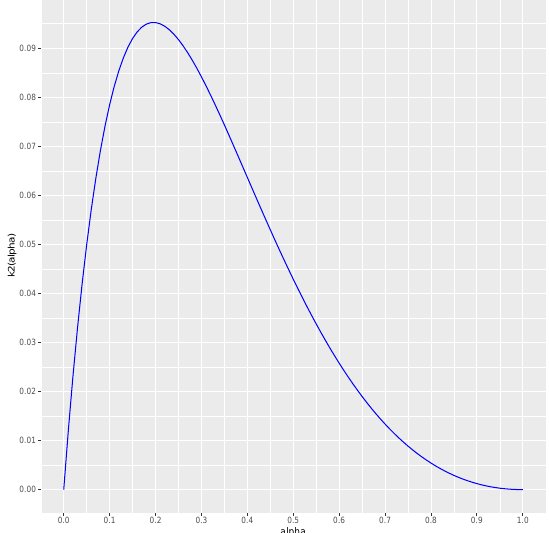
Figure 3.2: k 2 ( α ) = ϕ 1 (cid:0) ψ 1 ( α )/ n (cid:1) ) − ϕ 2 (cid:0) ψ 2 ( α )/ n (cid:1) for α ∈ [0, 1]